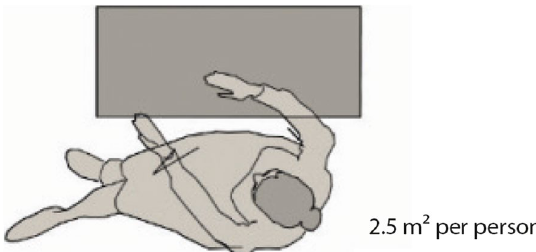
Fig. 11 Space requirement for wefting (Source: the author)